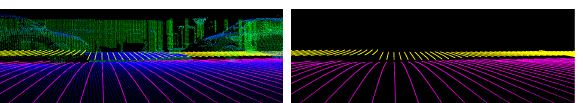
Figure 15: Inaccurate reconstruction. Point cloud is superimpose on the left.